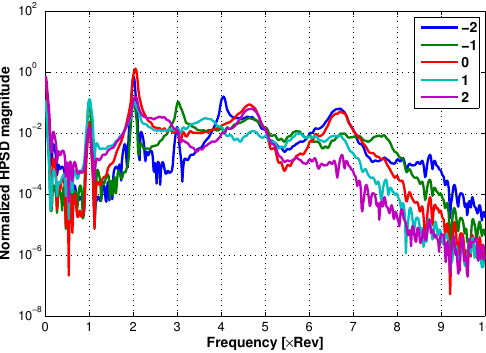
Figure 9. HPSD of the M d load, obtained for a 7ms − 1 average wind